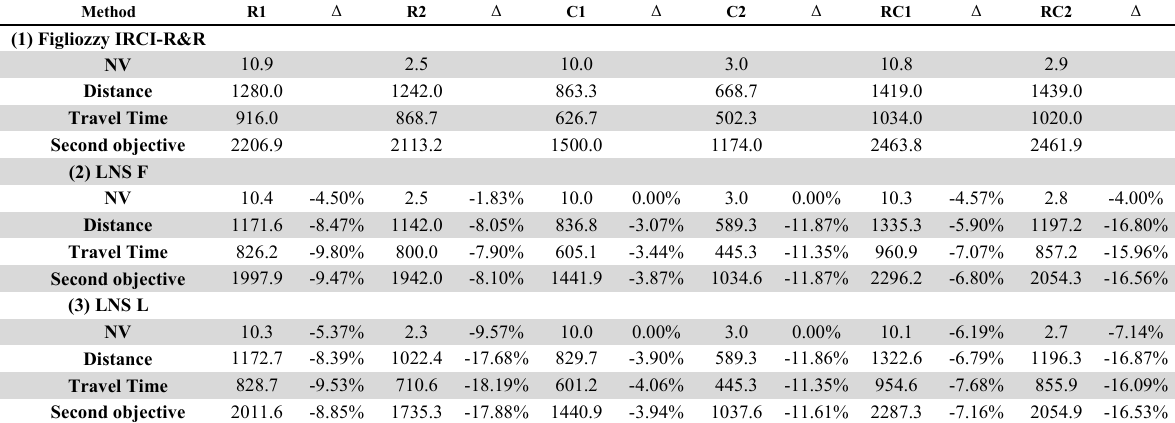
TDVRPTW Average results for 3 instances in Cases Type (c) 100 customers Method